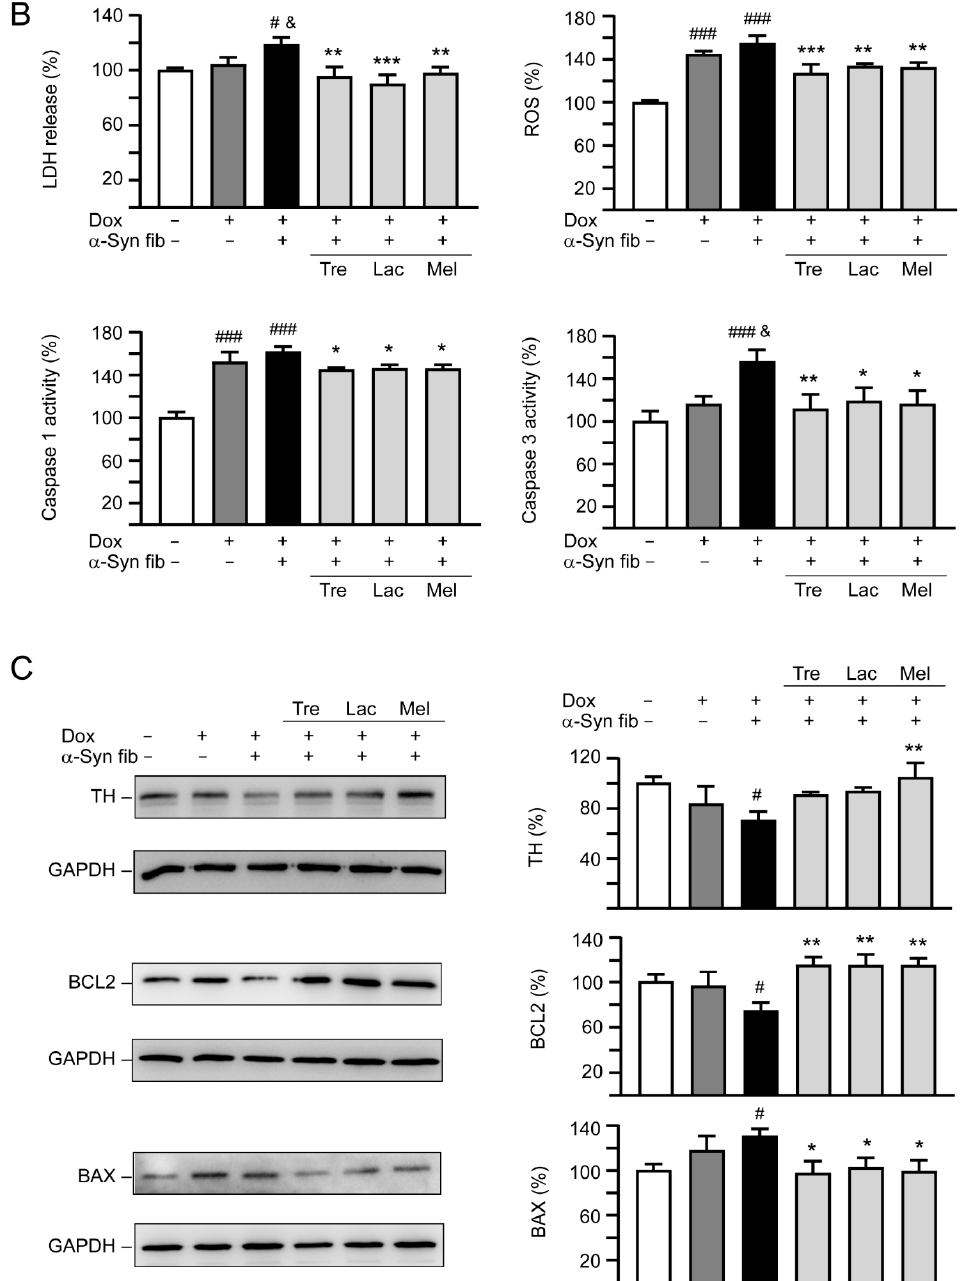
Figure 6. Neuroprotective effects of tested disaccharides in SNCA-GFP-expressing SH-SY5Y cells. On day 8, TPA-differentiated SH-SY5Y cells were pretreated with 100 μ M trehalose, lactulose, or melibiose for 8 h followed by induction of SNCA-GFP expression and addition of preformed α -synuclein fibrils for six days. Relative ( A ) neurite length, process, branch; ( B ) LDH release, ROS, caspase 1 / 3 activity; and ( C ) TH, BCL2, BAX protein levels were analyzed ( n = 3). GAPDH was included in immunoblot as an internal control. In ( B , C ), expression level in cells uninduced and without preformed fibril addition ( − Dox / − α -Syn fibrils) was set at 100% for normalization. p values: comparisons between − Dox / − α -Syn fibrils vs. + Dox / − α -Syn fibrils, or − Dox / − α -Syn fibrils vs. + Dox /+ α -Syn fibrils ( # : p < 0.05, ## : p < 0.01, ### : p < 0.001), between + Dox / − α -Syn fibrils vs. + Dox /+ α -Syn fibrils ( & : p < 0.05), or between + Dox /+ α -Syn fibrils-cells with and without disaccharide treatment (*: p < 0.05, **: p < 0.01, ***: p < 0.001). (one-way ANOVA with a post hoc Tukey